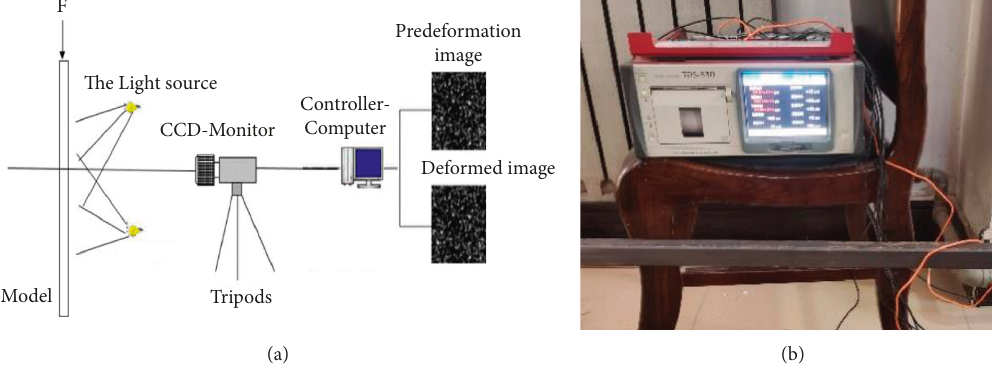
Figure 7: Schematic diagram of the measuring instrument: (a) noncontact precision measurement systems and (b) static strain gauge. ZJ1